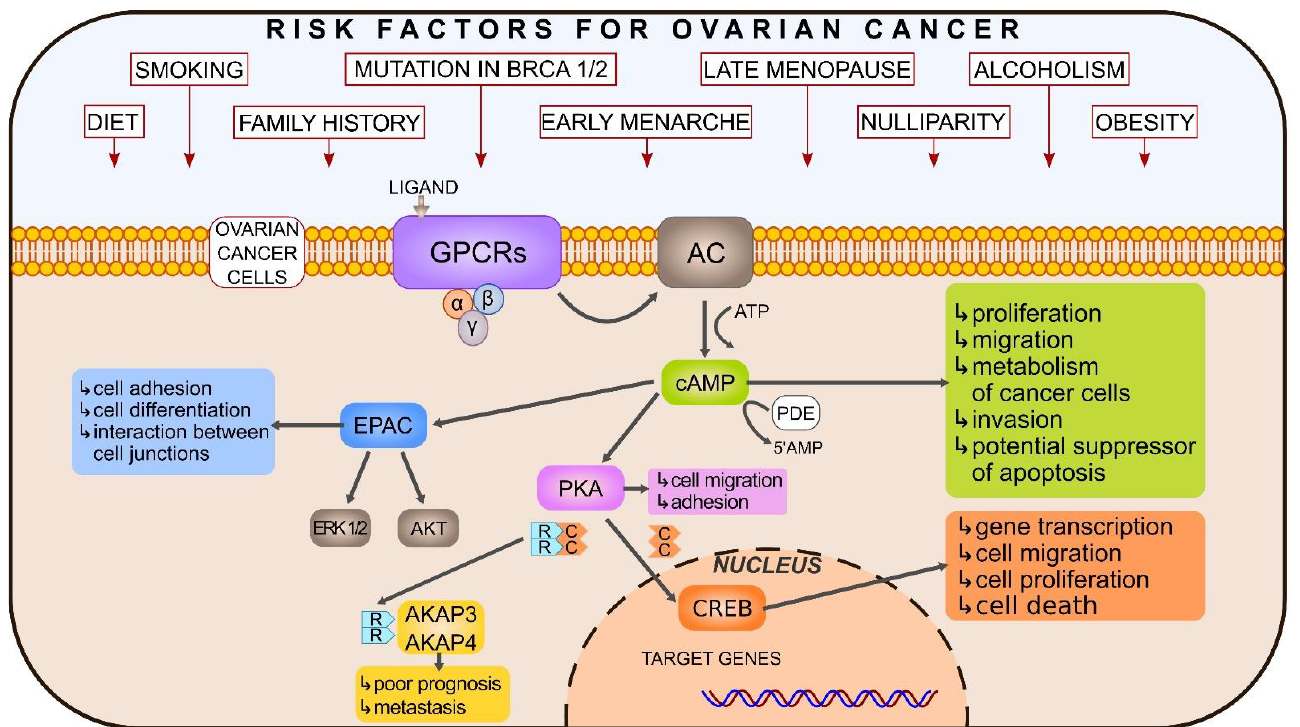
Figure 3. cAMP-dependent pathway in the ovarian cancer cell. Healthy ovarian cell exposed to the risk factors (red boxes) transforms phenotypically into neoplastic cell. Signaling cascades and maintenance of metabolism in the transformed cells may favor all features associated with growth, multiplication, metastasis, and survival. Activation of a cAMP-dependent pathway in the ovary occurs as a result of ligands (e.g., FSH and LH) binding to the G protein-coupled receptor. Changing the conformation of the receptor stimulates adenylate cyclase (AC) and increases cAMP concentra- tion.